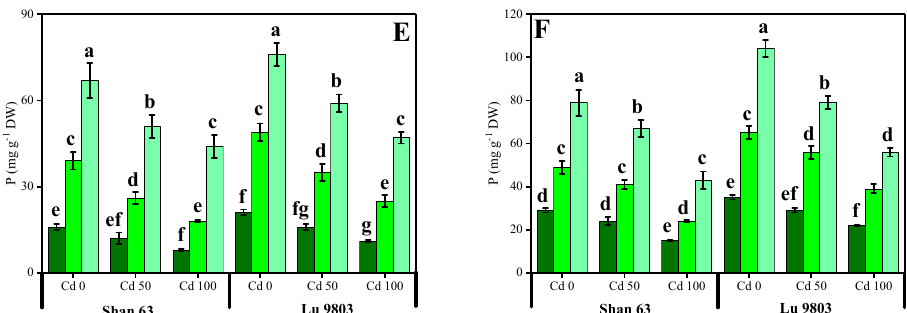
Figure 6. Effect of different concentrations of exogenous application of FeSO 4 (0, 50, and 100 µM) on ion uptake, i.e., iron contents in the roots ( E ), iron contents in the shoots ( F ), calcium contents in the roots ( G ), and calcium contents in the leaves ( H ), magnesium contents in the roots ( A ), magnesium contents in the shoots ( B ), phosphorus contents in the roots ( C ) and phosphorus contents in the shoots ( D ) of Oryza sativa (cultivars) grown under different levels of Cd stress (0, 50 and 100 µM). Bars sharing different letter(s) for each parameter are significantly different from each other according to Duncan’s multiple range test ( p < 0.05). All the data represented are the average of four replications ( n = 4). Error bars represent the standard deviation (SD) of four replicates.